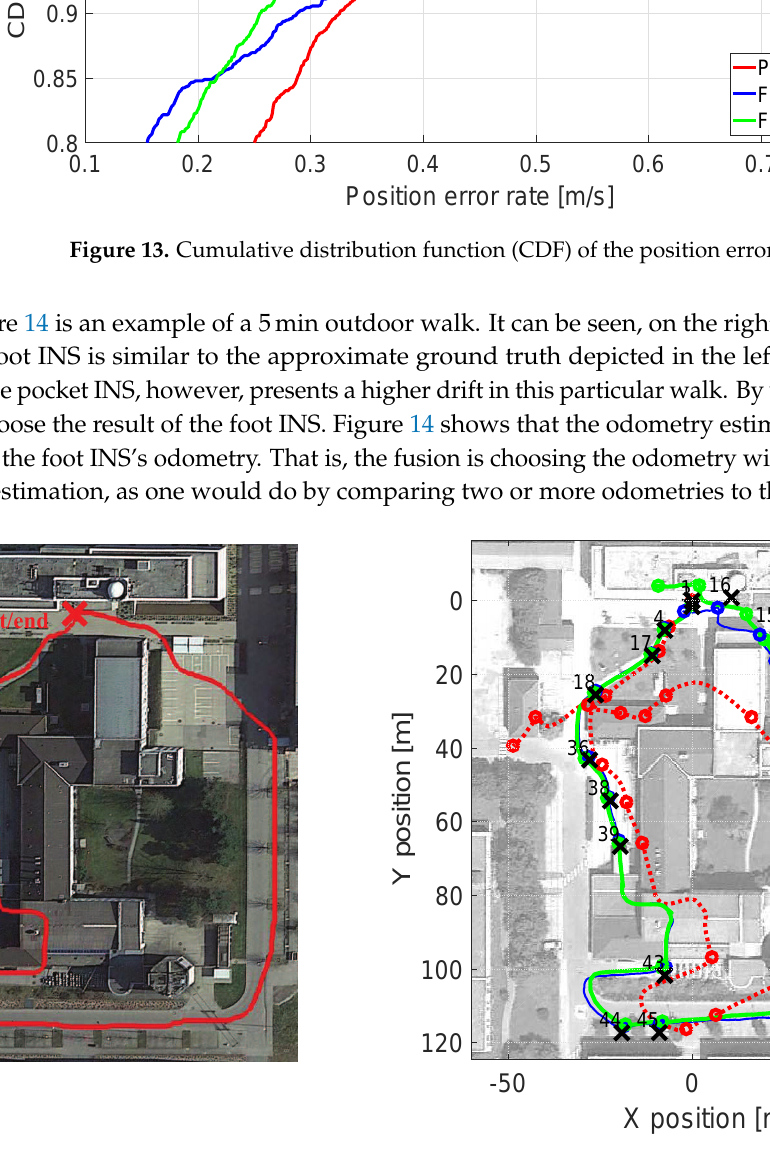
Figure 14. ( Left ) Approximate ground truth; ( Right ) Odometry estimated by each of the INS under evaluation. The dotted-red line is the pocket INS estimation. The thin-blue line is the foot INS estimation. The thick-green line is the loosely coupled fusion estimation. The cross marks indicate the ground truth points (GTP) visited during the walk. The circle marks indicate the estimated position of the